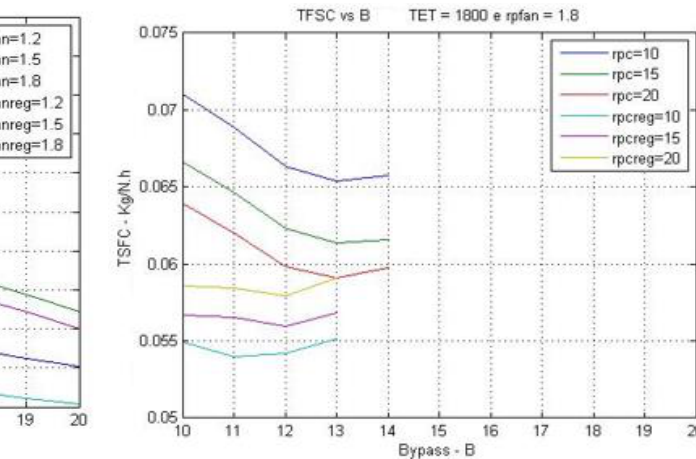
Figure 8: TSFC vs BPR with and without regeneration (TET 1800 K and rpfan 1.8).